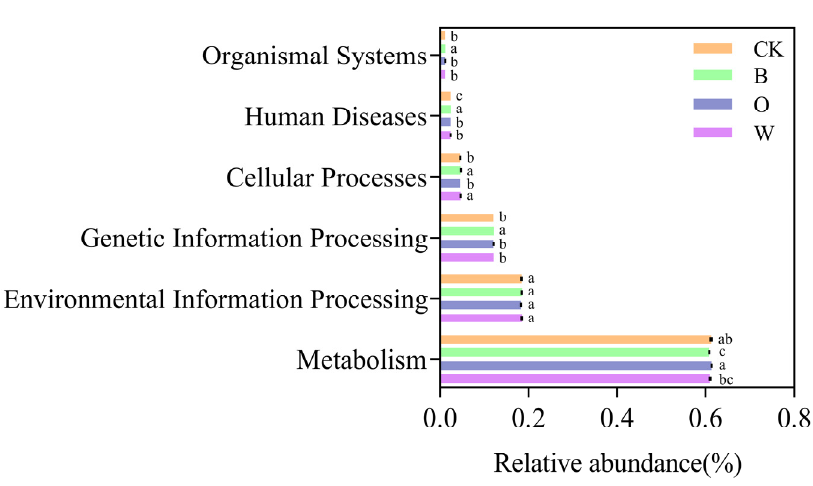
Figure 8. Soil bacterial function prediction of soil in different treatments (Hierarchy Level 1). CK represents Chinese cabbage continuous cropping; B, O, and W represents bean, potato onion and wheat rotation, respectively. Different letters are significantly different ( p < 0.05, Tukey’s HSD test).